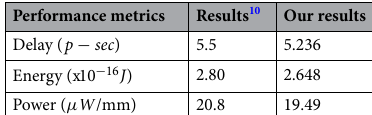
Table 2. Calibration of our results (FeCl 3 doped interconnect) with 10 at 11 nm technology node.